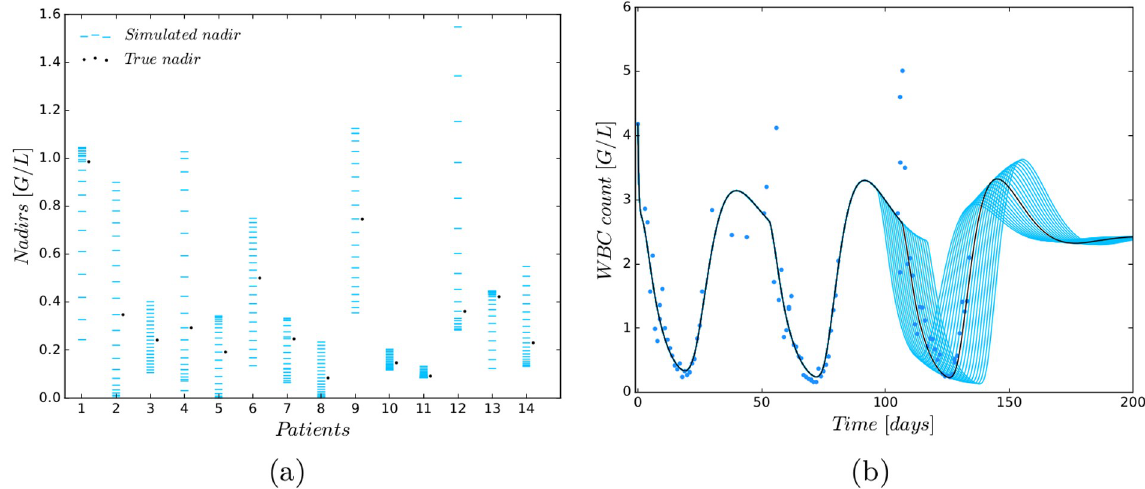
Fig 5. Analysing the influence of treatment timing on nadir values. ( a ) Simulation study in which 20 simulated nadirs were compared with the true nadir of the last CC for the 14 patients who have more than one CC. The simulated nadirs were computed by using the patient’s PM (second row of Table 3) and varying the start of the last CC daily with the maximal starting variation of 10 days earlier or later. ( b ) Exemplary variation of the CC start for one patient. An earlier (later) start results in a larger (lower) nadir.